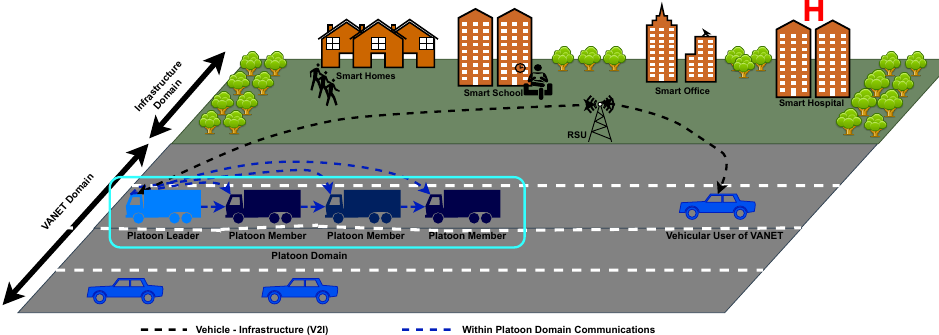
Figure 2. Current Example of Vehicular Platooning within a Smart